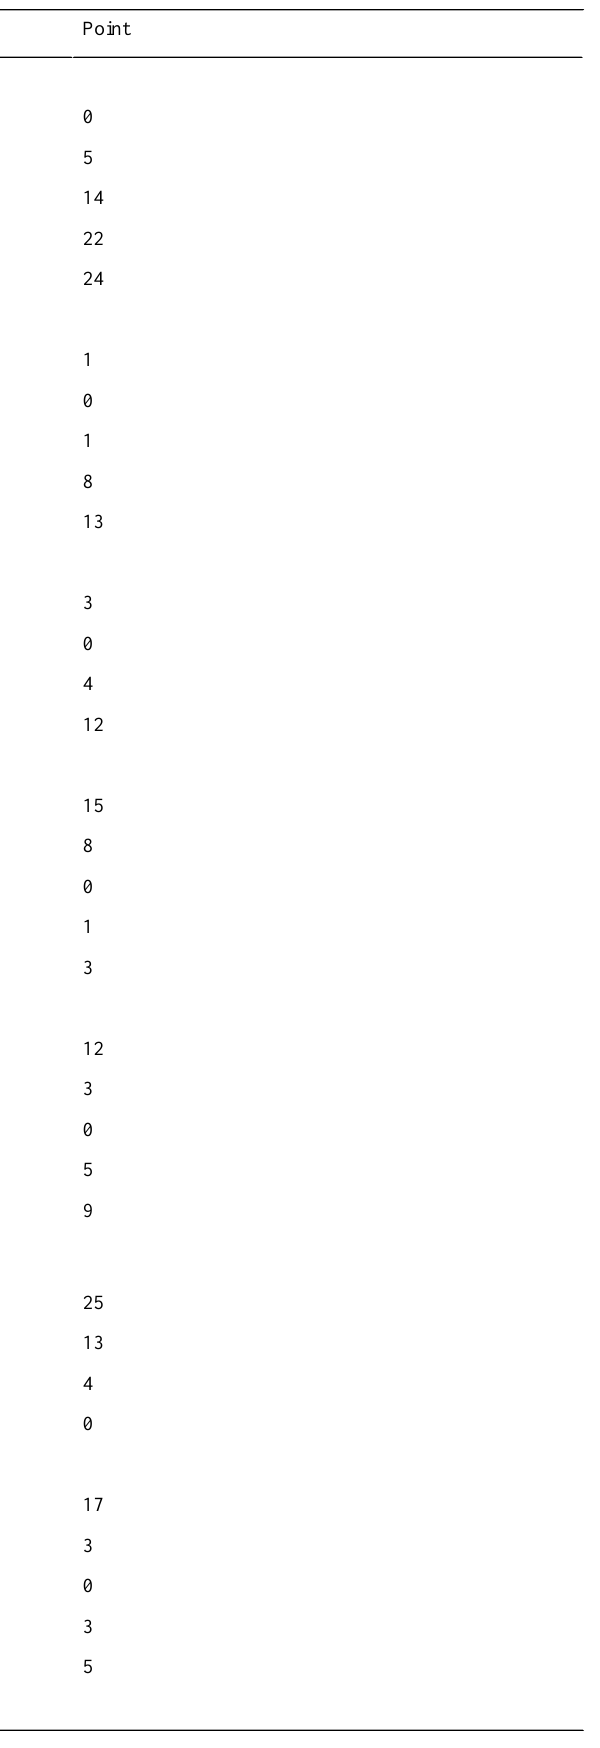
Table 4. A nine-variable AutoScore-created scoring model for inpatient